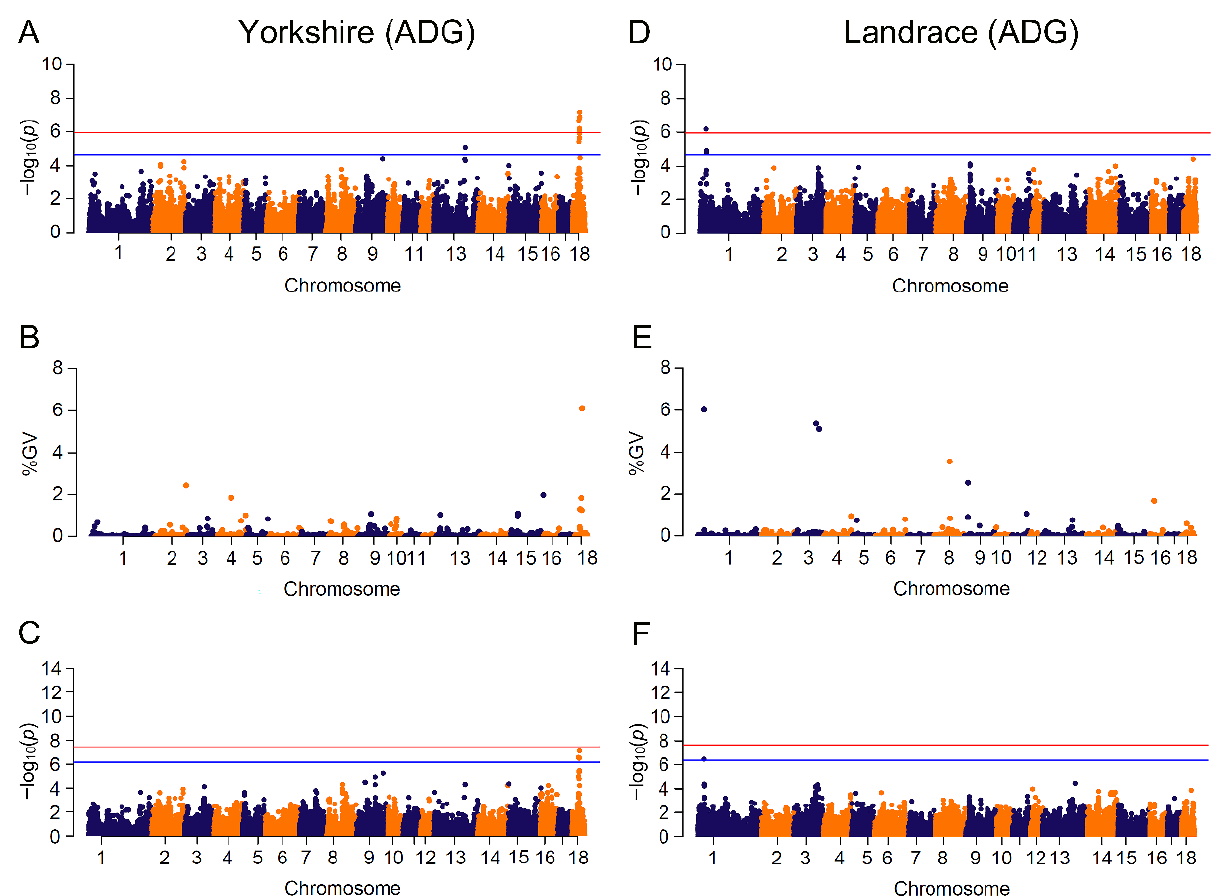
Figure 2. Manhattan plots for ADG (average daily gain) by breed in different GWAS approaches. The red and blue lines in plots represent genome-wide and suggestive significance thresholds, respectively. Results in Yorkshire population for: ( A ) CL_GWAS; ( B ) CB_GWAS; ( C ) IL_GWAS. Results in Landrace population for: ( D ) CL_GWAS; ( E ) CB_GWAS; ( F ) IL_GWAS. %GV denotes the proportion of genomic variance explained by the region identified.